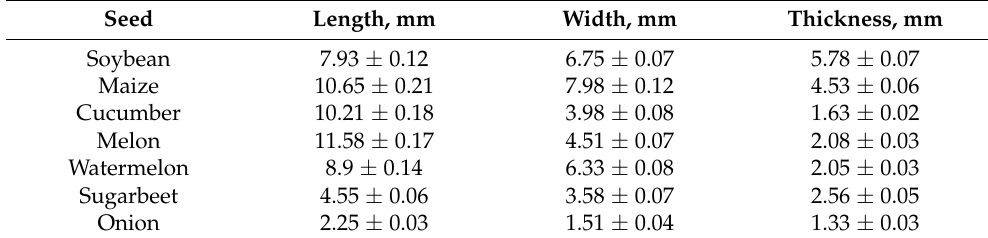
Table 1. Dimensions of seeds.